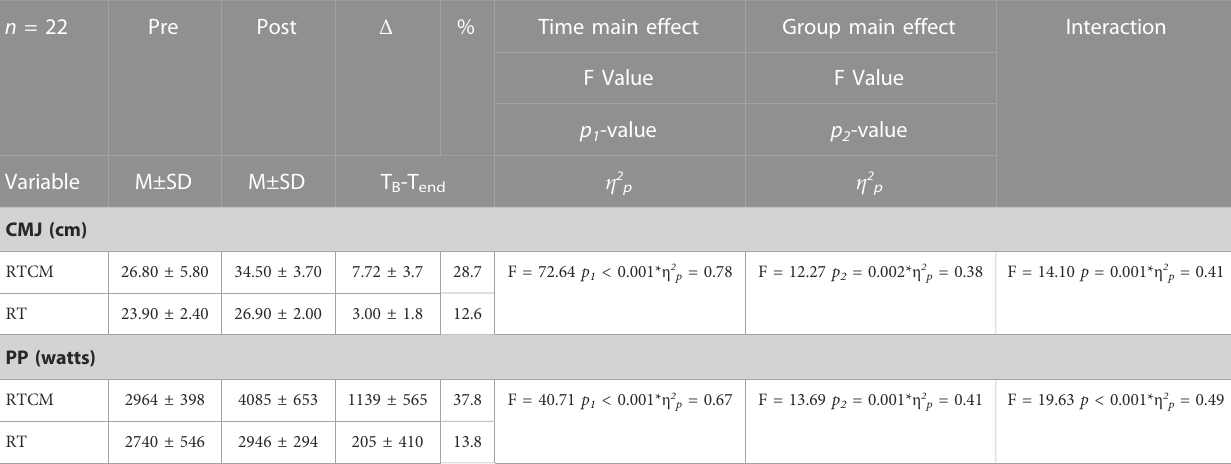
TABLE 5 Baseline and posttest CMJ and PP results.